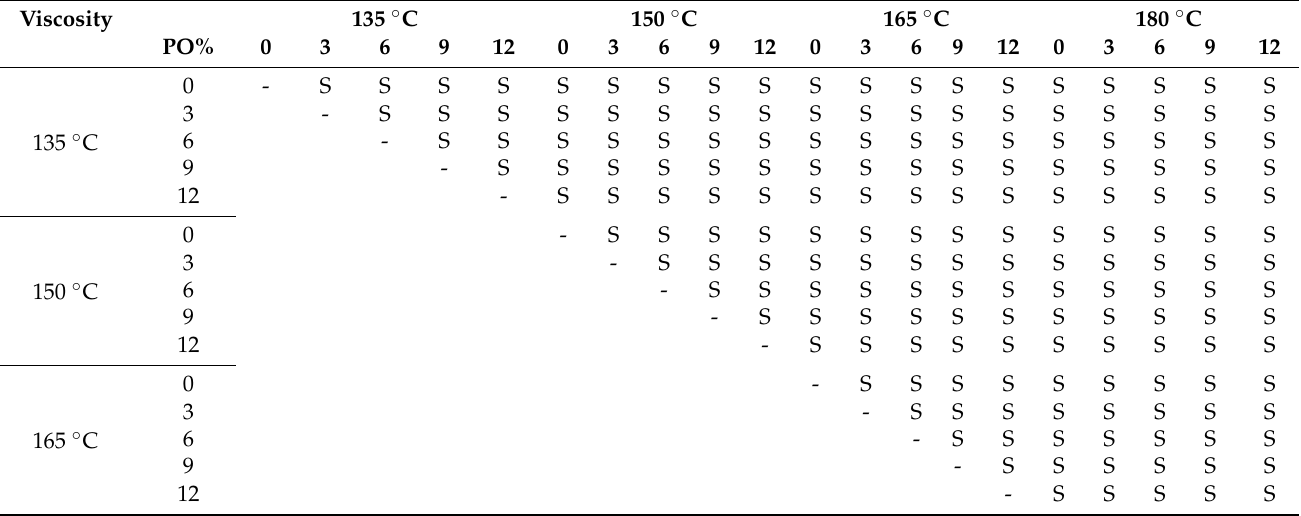
Table 4. Statistical analysis results of the RV test for PG 76-22 as a function of processed oil content ( α =